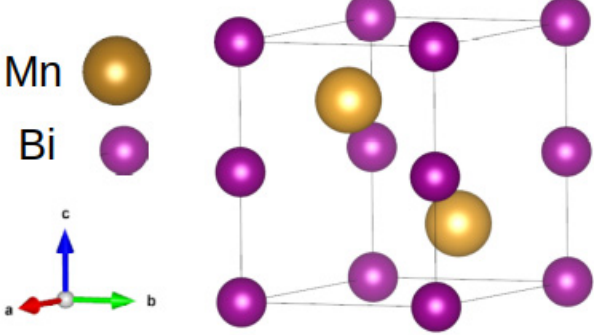
Figure 3. Crystal structure of the low-temperature MnBi phase.